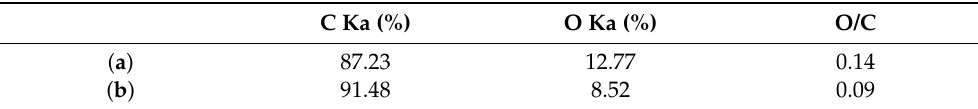
Table 1. EDS Surface Element Analysis Results